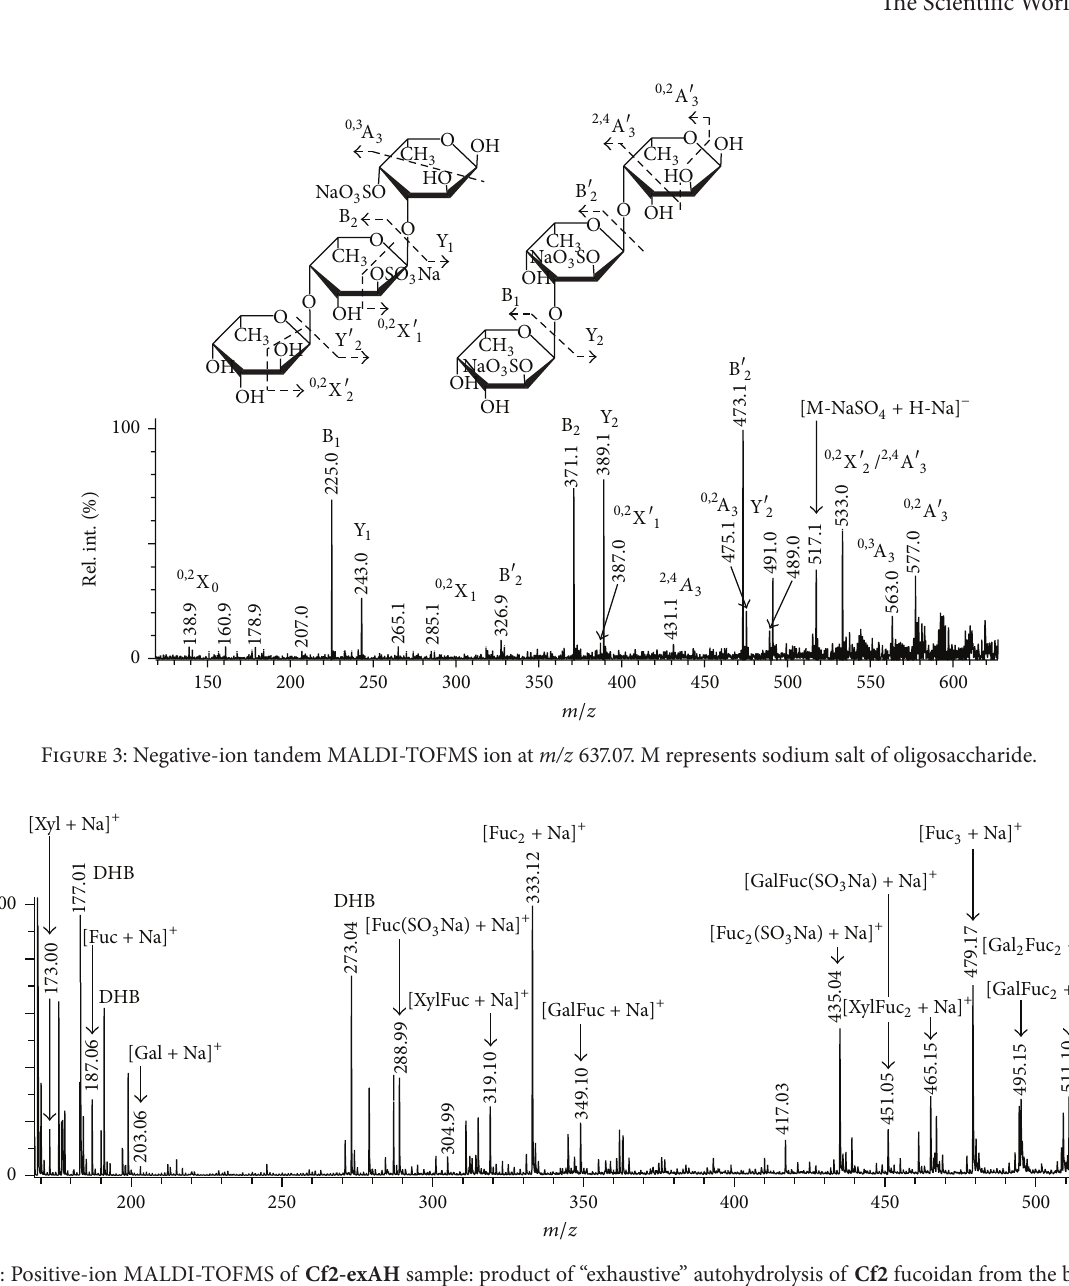
Figure 4: Positive-ion MALDI-TOFMS of Cf2-exAH sample: product of “exhaustive” autohydrolysis of Cf2 fucoidan from the brown alga C. langsdorfii .